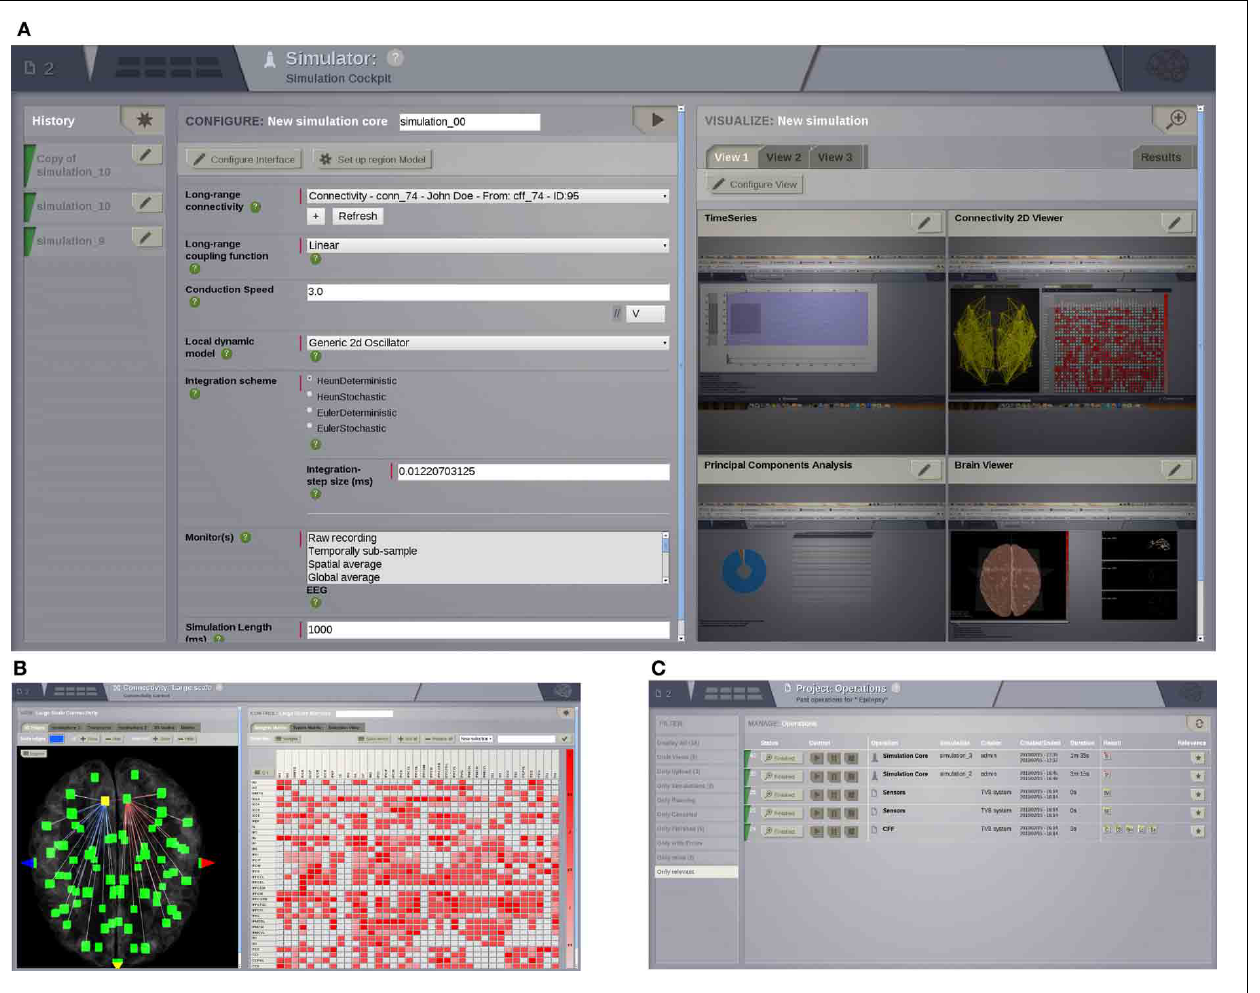
FIGURE 3 | UI screenshots. (A) SIMULATOR Area. Having multiple panels allows a quick overview of previous simulations (left), model parameters for the currently selected simulation (middle), and summary displays of the data associated with the currently selected simulation (right). (B) Shows the